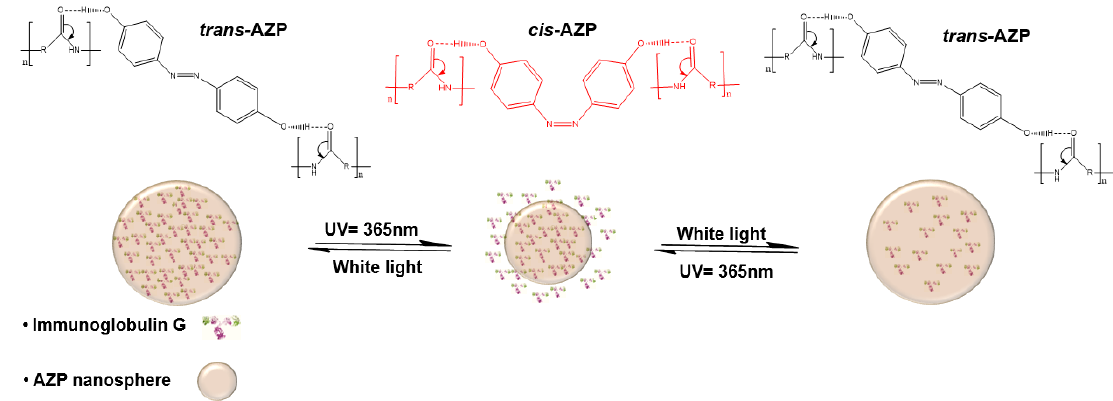
Figure 11. Schematic representation of the transformation from trans to cis to tran s and change in the size of AZP nanospheres upon UV irradiation and white light.